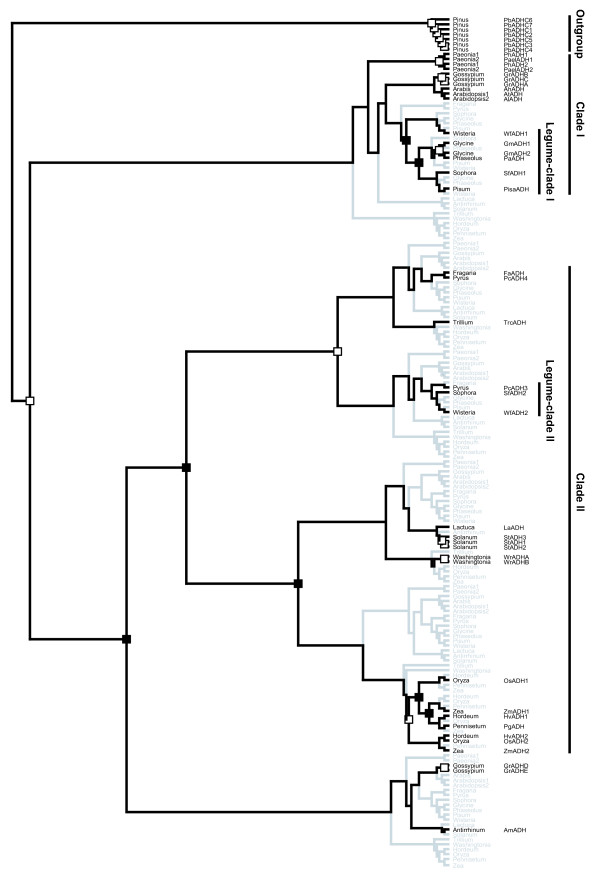
Part of the simplest reconciled tree that has the lowest number of duplication and deletion events. The reconciled tree involves 24 gene duplications and 44 gene losses for a total cost of 68, and requires 40 deep coalescenses. The solid boxes indicate gene duplications that were inferred on the basis of mismatches between the gene tree and the species tree. The open boxes indicate those duplications that required multiple copies of Adh genes within the same species. The gray lines indicate the lineages that are presumed to be lost after the duplications or were not found in our analysis.